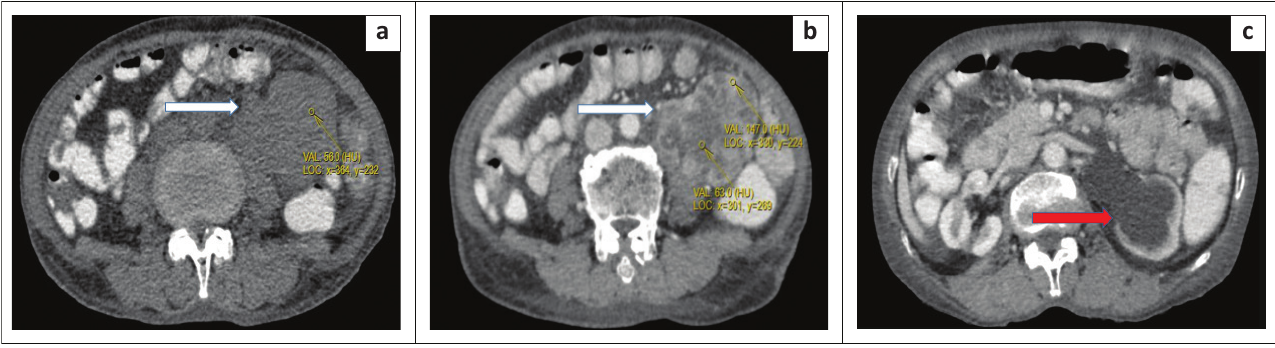
FIGURE 3: (a–c) Axial CT of abdomen showing a well defined solid retroperitoneal mass (white arrow) anterior to the left psoas and medial to the descending colon appearing isodense to muscle on pre-contrast (a), showing heterogeneous post contrast enhancement (b), causing proximal left hydronephrosis and hydroureter (red arrow)